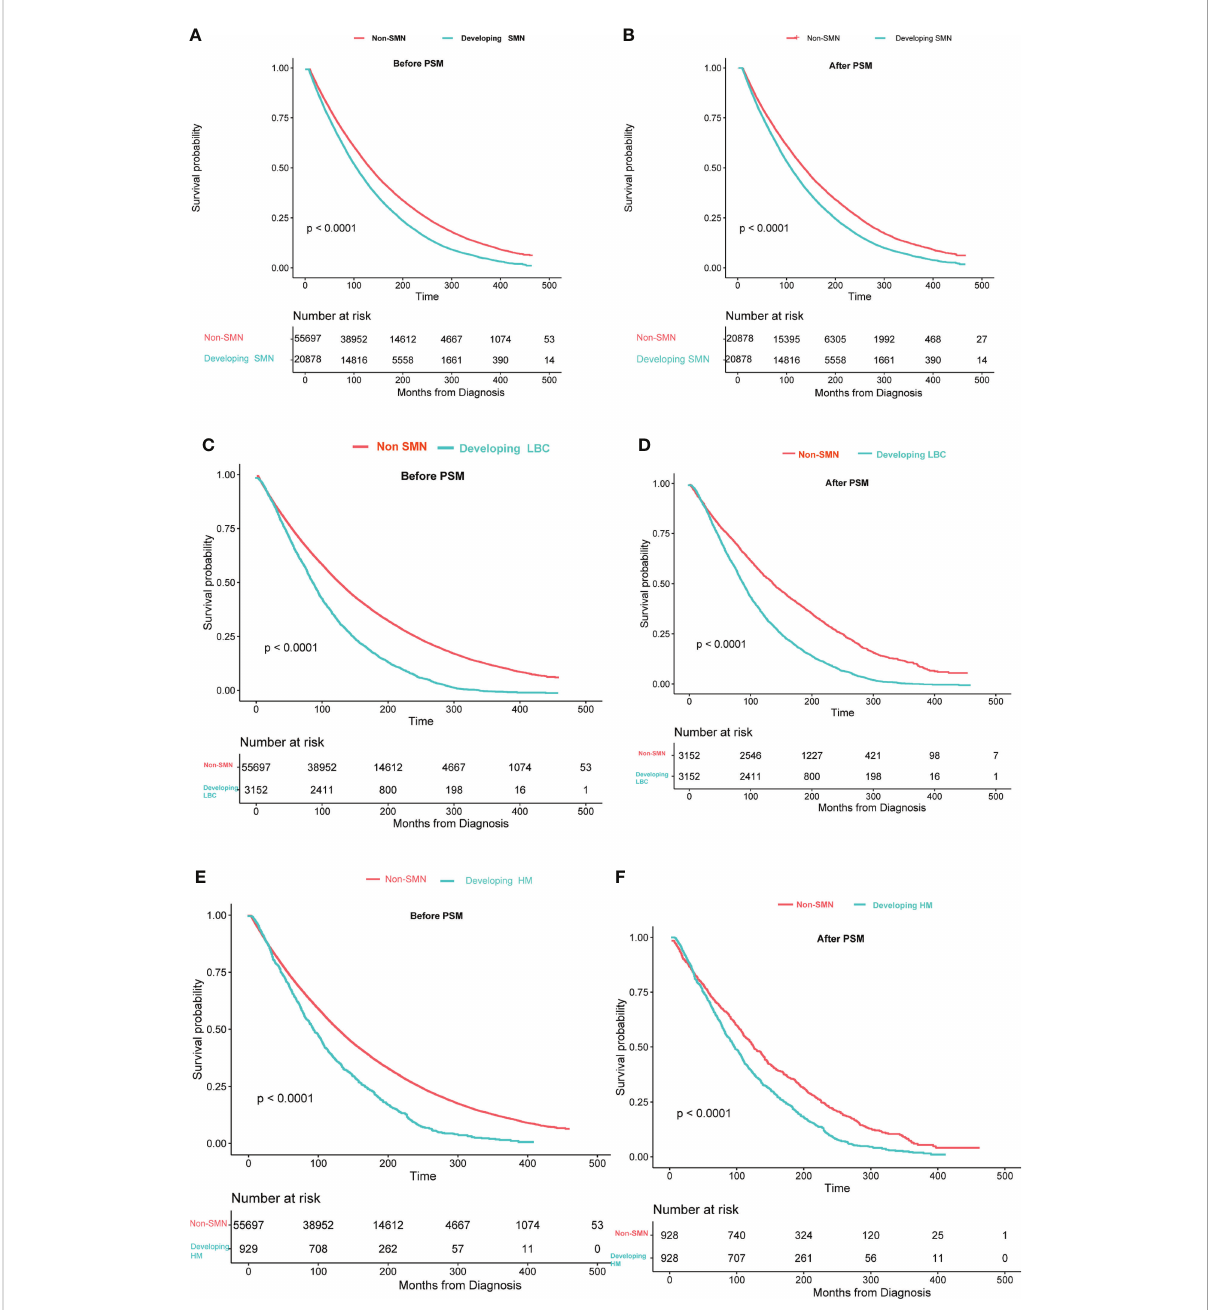
FIGURE 3 Overall survival between patients with only bladder cancer and developing second malignant neoplasm: (A) all SMNs before PSM; (B) all SMNs after PSM; (C) lung and bronchus cancer before PSM; (D) lung and bronchus cancer after PSM; (E) hematological malignancies before PSM; (F) hematological malignancies after PSM. The time on the x-axis begins 60 months after bladder cancer